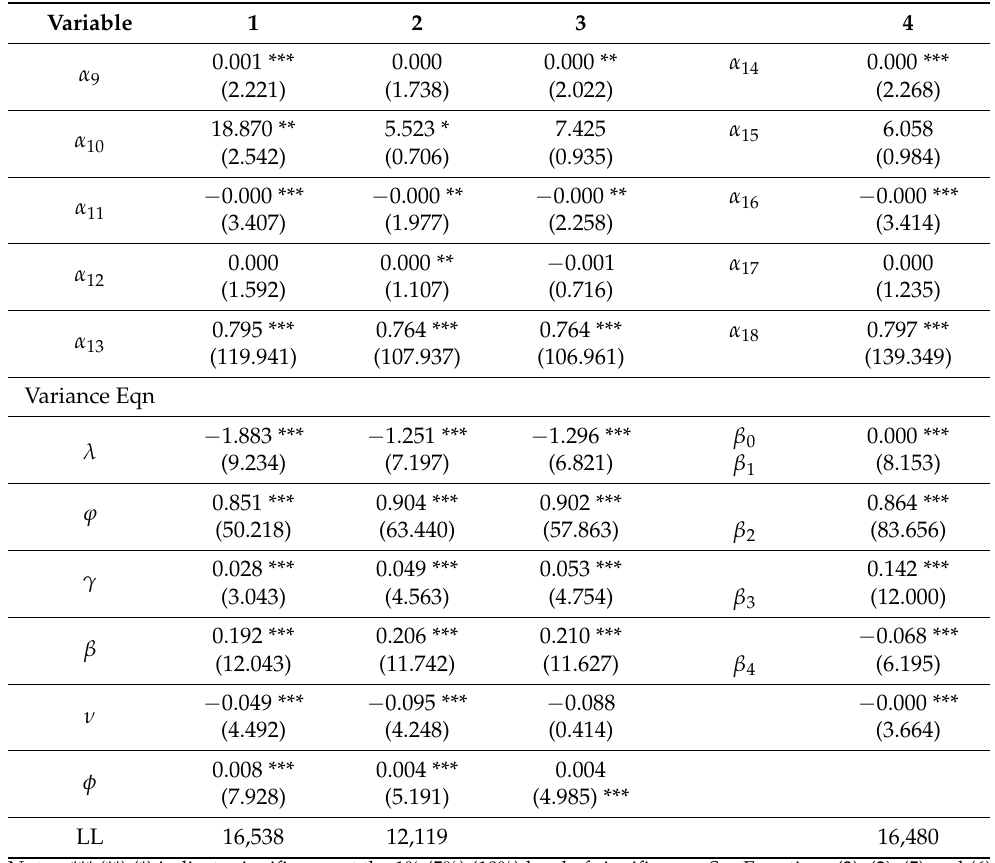
Table 4. Estimates of the event study using the EGARCH/GARCH model with STOXX returns.